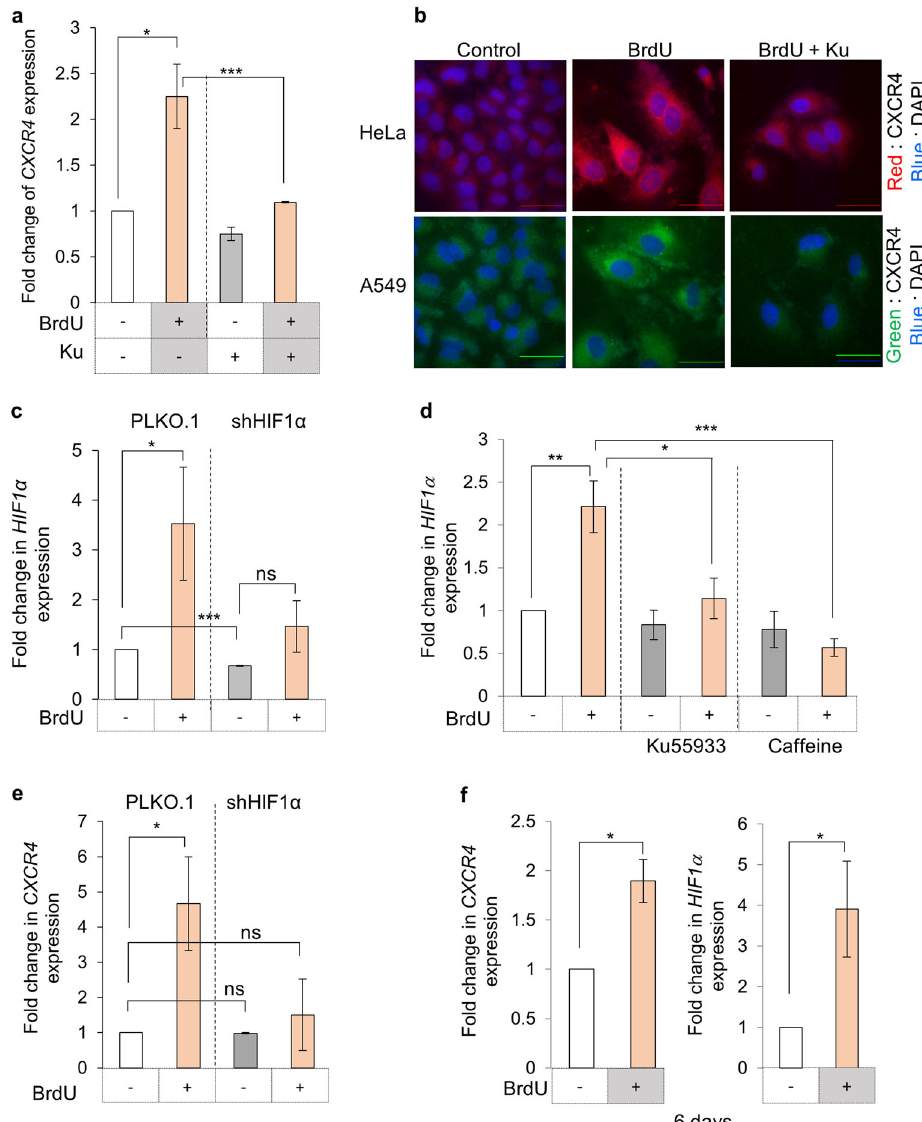
Fig. 2 DNA damage response and CXCR4 expression. a Effect of ATM kinase inhibition on CXCR4 levels during DNA damage. CXCR4 expression analysis was performed by qRT-PCR in HeLa cells treated with BrdU and ATM kinase inhibitor as indicated. b Immuno fl uorescence analysis of CXCR4 expression. HeLa and A549 cells treated as indicated and probed for CXCR4 expression as described in Fig. 1E. Scale bar = 40 µm ( n = 5). HeLa cells were probed with TRITC conjugated anti-CXCR4 antibody (red), while A549 cells with FITC – conjugated anti-CXCR4 antibody (green). c Analysis of HIF1 α expression during DDR. Expression analysis of HIF1 α in HeLa cells containing vector alone for HIF1 α targeting shRNA after treatment with BrdU was performed by qRT-PCR ( n = 3). d Effect of ATM kinase inhibition on HIF1 α expression. HF-hTERT cells were treated with BrdU and treated with either Ku or caffeine. HIF1 α expression was evaluated by qRT-PCR. ( n = 3). e Analysis of CXCR4 expression wrt HIF1 α levels. CXCR4 expression during BrdU induced DDR was analysed in HeLa cells stably expressing shRNA against HIF1 α by RT-PCR ( n = 3). f CXCR4 and HIF1 α expression analysis after prolonged BrdU treatment. Expression analysis of CXCR4 (left) and HIF1 α (right) was performed in HeLa cells treated with BrdU for 6 days by qRT-PCR and compared with untreated cells ( n = 3). For all experiments results shown are mean ± s.e.m. p value ns < 0.5; * p ≤ 0.05; *** p ≤ 0.001 (Student ’ s t -test; n =